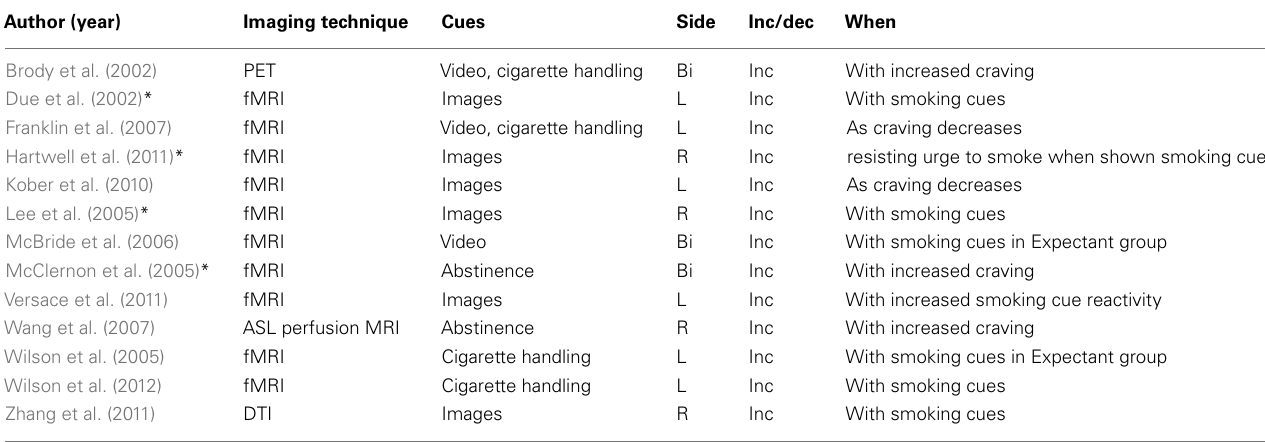
Table 1 | Dorsolateral prefrontal cortex implication in smoking cue reactivity – studies reporting DLPFC activation in response to smoking